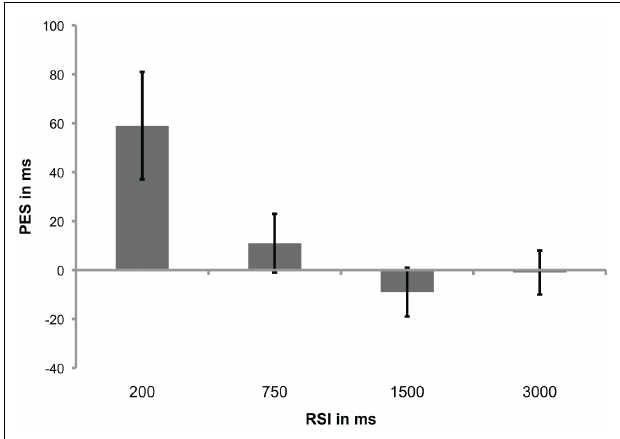
FIGURE 2 | Mean post-error slowing (PES) values (and SEM) for each response–stimulus interval (RSI). PES for RSI 200 is significantly larger than for RSI 1500 and 3000 (both p < 0.005), and there is a trend for a difference between RSI 200 and 750 ( p = 0.088).There is also a marginally significant difference between RSI 750 and 1500 ( p = 0.088). RSI 1500 and 3000 do not